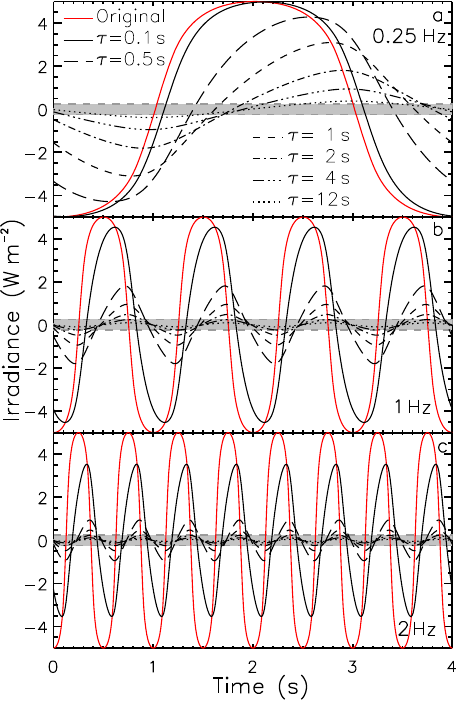
Figure 1. Original synthetic time series (red) and convoluted time series (black) of irradiance for three different frequencies f p = 0.25/1/2Hz ( a–c ). The different black lines show convoluted time series for different response times τ between 0.1 and 12s. The gray area indicates a hypothetical noise level of 0.25Wm − 2 .